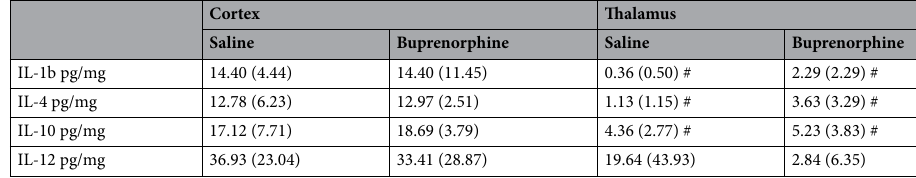
Table 2. Cytokine concentrations in cortex and thalamus of saline and buprenorphine treated animals at 1d following CFPI. n = 6 rats/group. Data presented as mean (SD) pg of cytokine per mg of total protein. Regional differences: # p < 0.05 compared to